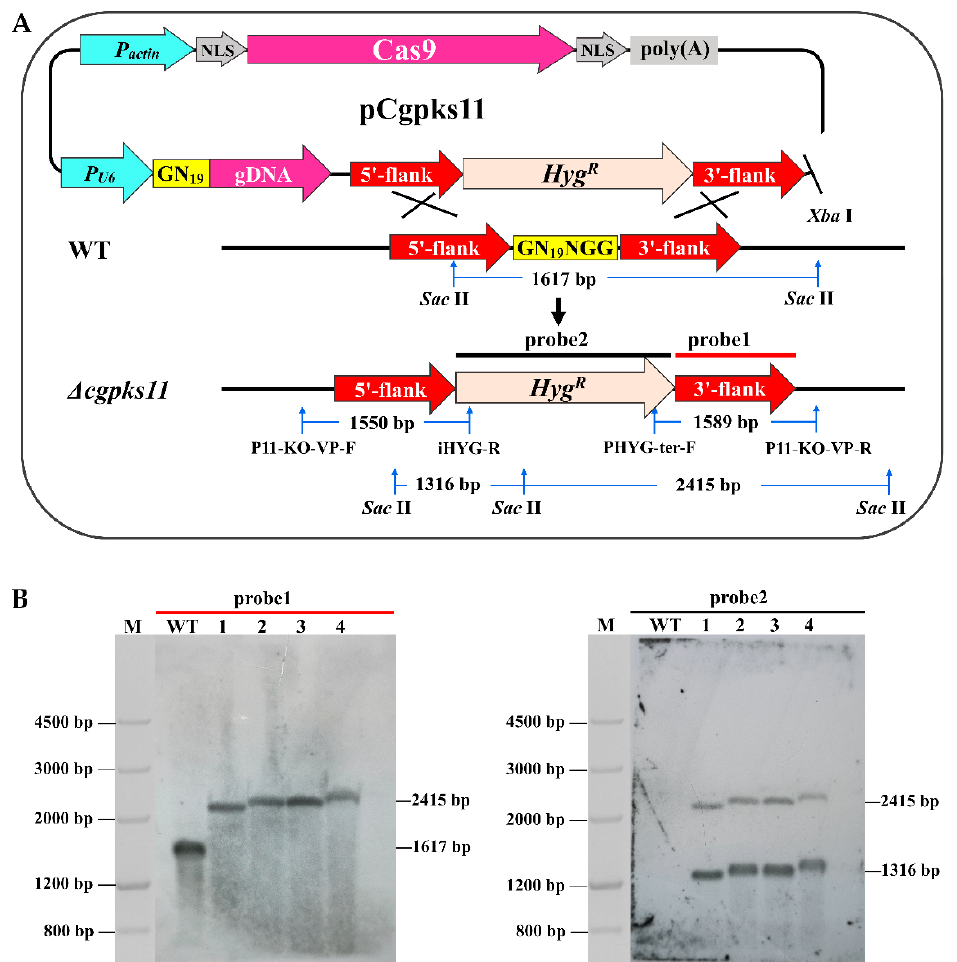
Figure 3. Targeted deletion of Cgpks11 in C. globosum via a “suicide” CRISPR/Cas9 system. ( A ) Diagram of the targeted deletion of Cgpks11 via the CRISPR/Cas9-mediated homologous recombination. ( B ) Southern blot analysis of ∆ cgpks11 mutants. M: Marker III. Lanes 1 to 4 were loaded samples of transformants NO11, NO12, NO15, and NO16, respectively.